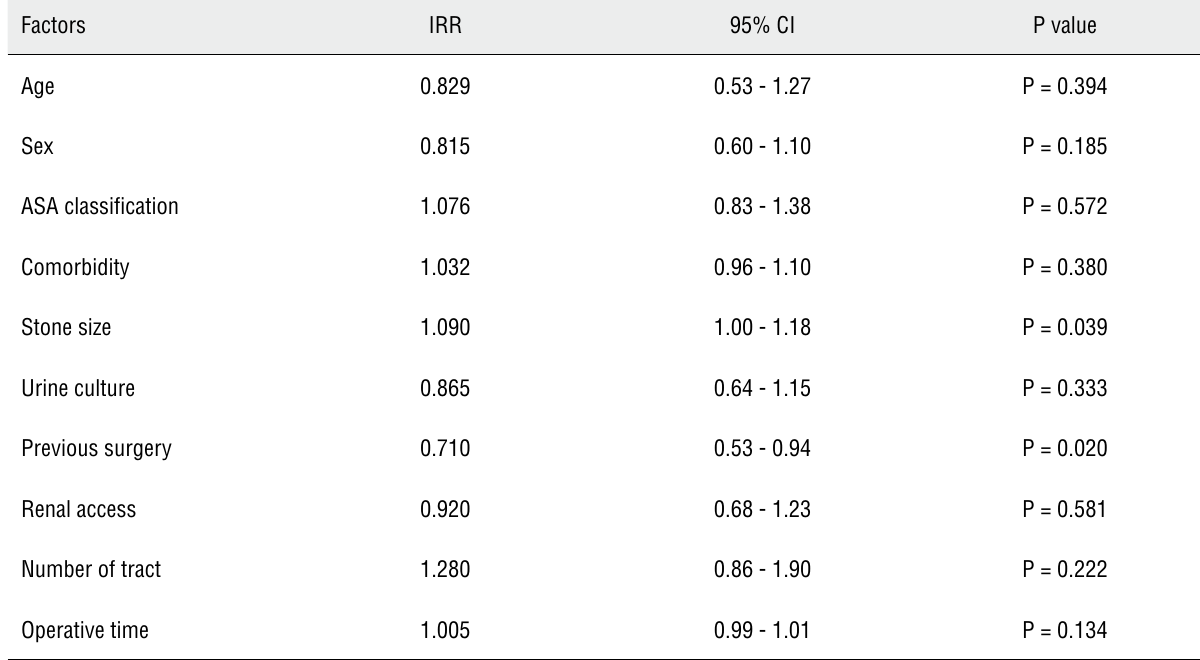
Table 5 - Multivariate analysis of success rate in association with demographics, stone, pre-operative and operative characteristics.